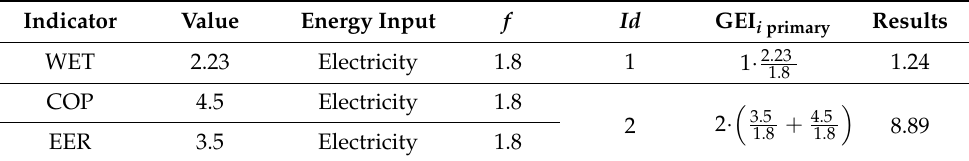
Table 6. GEI s calculation for the modified second plant